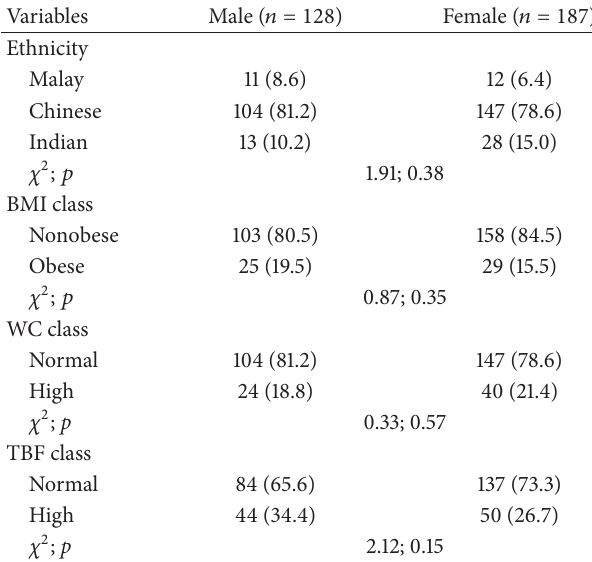
Table 1: Demographic and anthropometric characteristics of the subjects according to